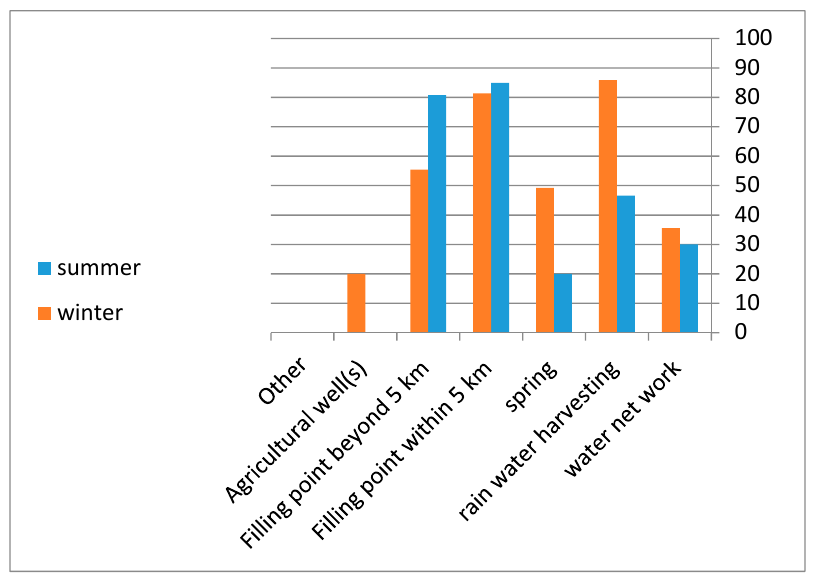
Figure 1. Water resources used by surveyed households depending on the season.